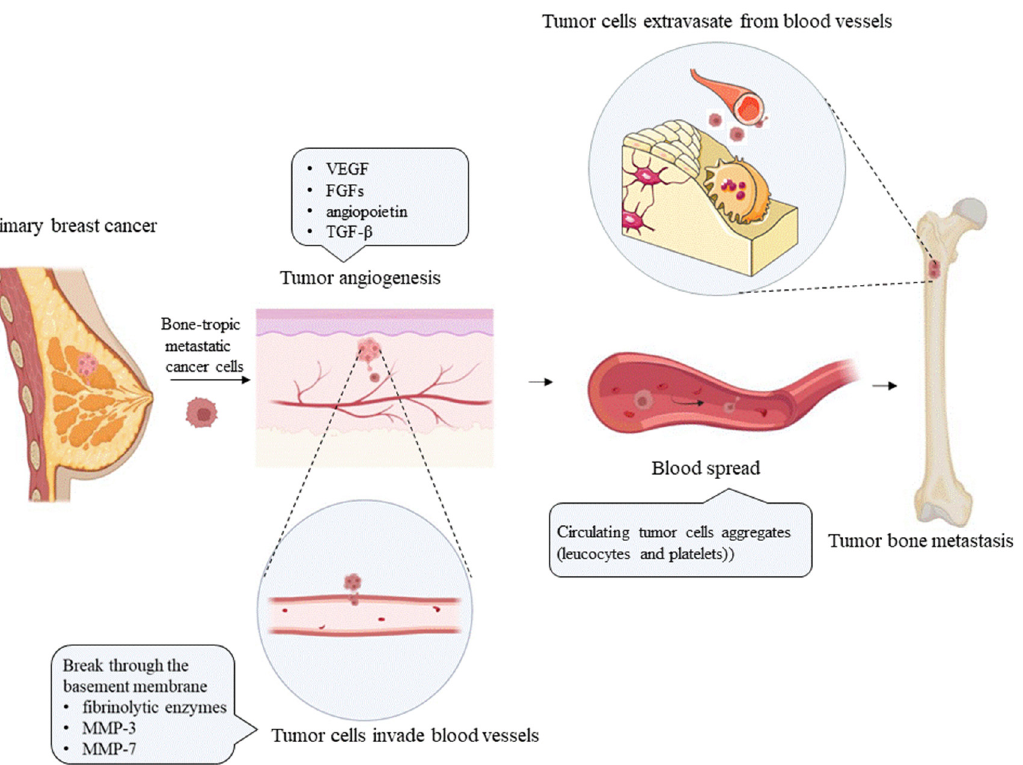
Figure 1. The process by which breast cancer cells migrate from the primary site to the bone. Tumor cells continue to proliferate and convert into a mesenchymal phenotype, and tumor angiogenesis is promoted upon stimulation with VEGF, FGFs, angiopoietin, and TGF −β [20]. Tumor cells interact with the surrounding stroma, to promote tumor cell migration, and intravasate through the vascular wall to enter the circulatory system, by producing fibrinolytic factors and MMP − 3 and MMP − 7. Circulating tumor cells interact with blood cells, such as lymphocytes, neutrophils, and platelets, to form multicellular aggregates and promote tumor survival. Metastatic cancer cells enter the bone via the blood circulation; arrest in distant capillaries; extravasate into the bone marrow through the vascular system; interact with cells in the bone microenvironment, such as osteoblasts and stromal cells; and then survive and activate osteoclasts; finally resulting in osteolytic metastasis. MMP − 3 = matrix metalloproteinase 3; MMP − 7 = matrix metalloproteinase 7; VEGF = vascular endothelial growth factor; FGFs = fibroblast growth factors; TGF −β = transforming growth factor beta.